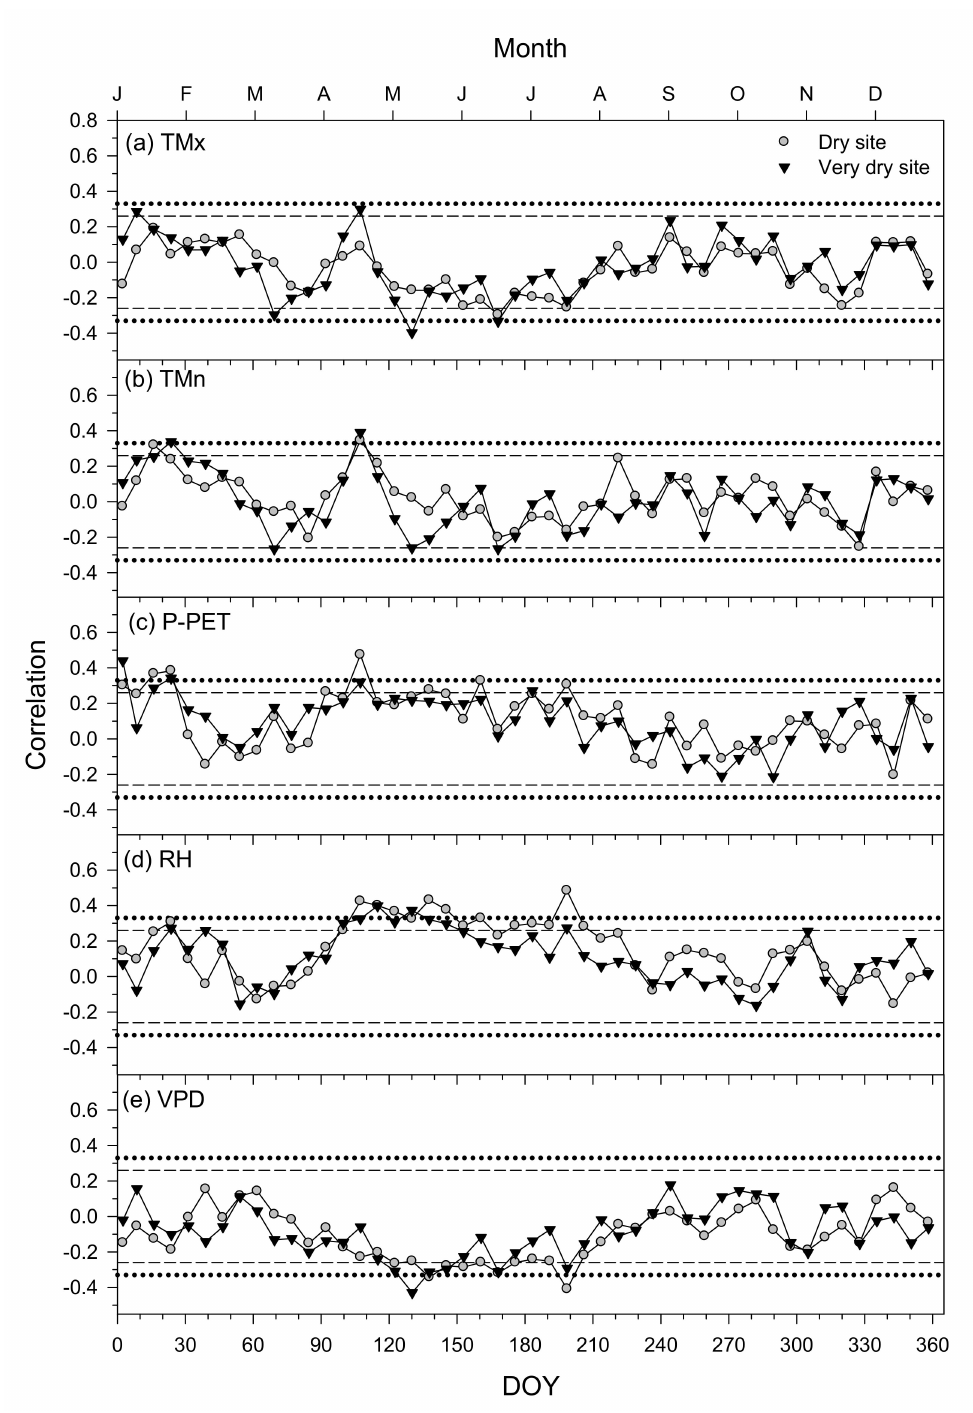
Figure 9. The climate–growth relationships of Juniperus thurifera were assessed at a weekly resolution at the dry and very dry sites. The analyzed climate variables were ( a ) TMx, ( b ), TMn, ( c ), P-PET, ( d ) RH, and ( e ) VPD. The horizontal dashed and dotted lines indicate the 0.05 and 0.01 significance levels,